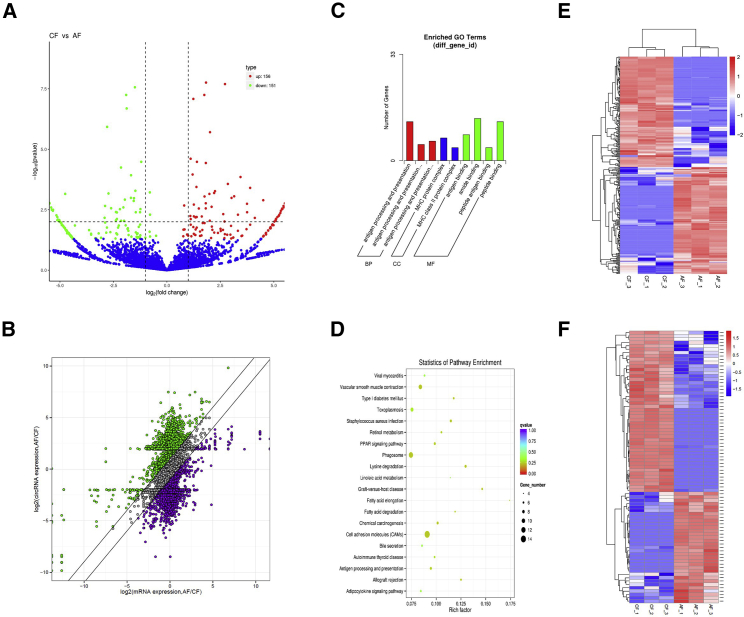
Differentially Expressed circRNAs in Bovine Fatty Tissues(A) Differential expression analysis using DESeq2. Volcano plot shows the correlation of abundances of individual circRNAs in adult or calf period. (B) Analysis of the impact of mRNA host gene expression change on circRNA expression change in fatty tissue. (C and D) GO (C) and KEGG (D) terms of significantly differentially expressed circRNAs (p < 0.05). (E) Clustered heatmap of differentially expressed circRNAs (p < 0.05). (F) Clustered heatmap showing abundances of the corresponding linear host transcripts of the 100 most differentially expressed circRNAs (p < 0.05).